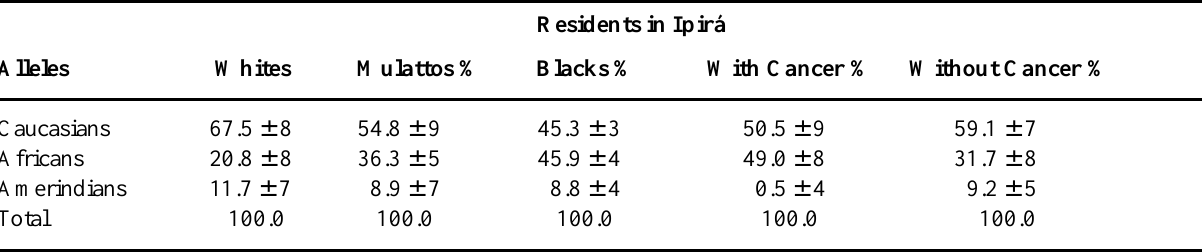
Table 1 - Analysis of gene admixture in “Whites”, “Mulattos” and “Blacks” from Ipirá, Bahia, Brazil, as classified under an anthropological